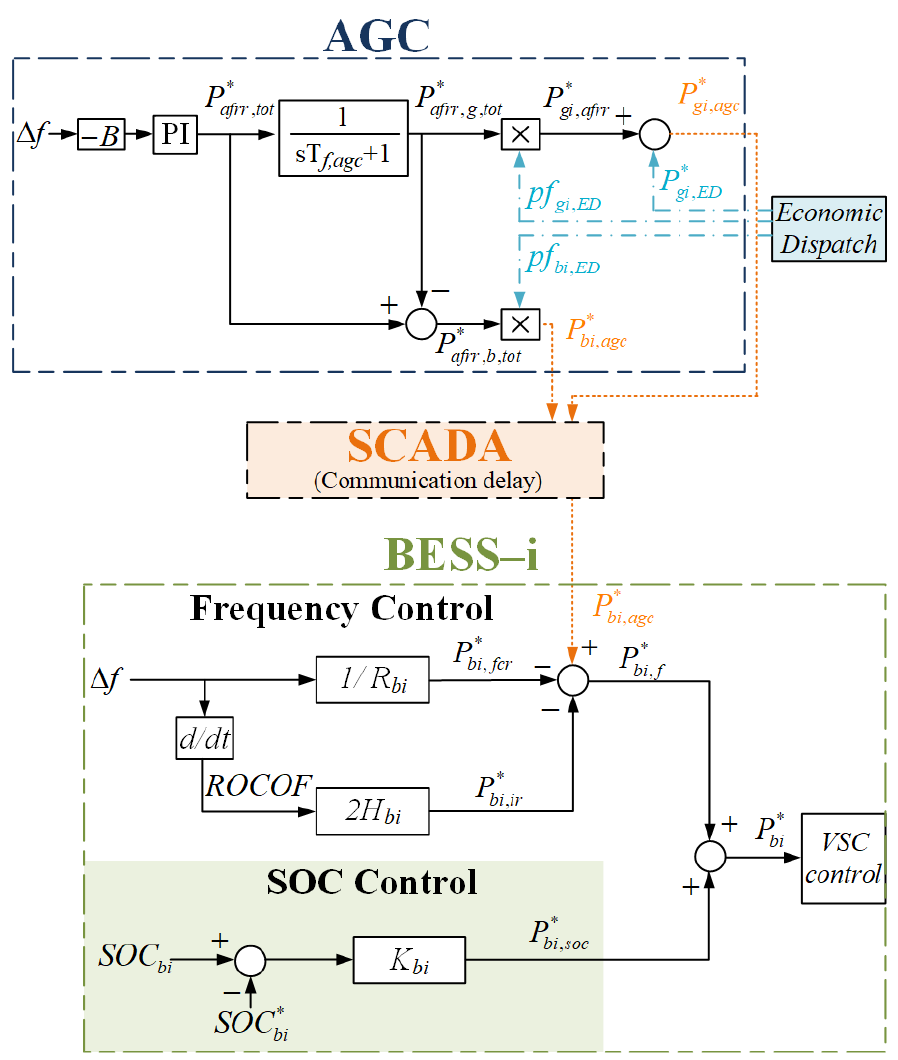
Figure 4. Filter-based AGC method.